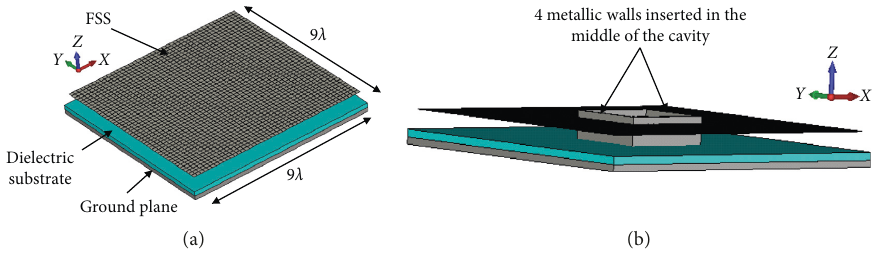
Figure 2: (a) High-gain EBG Antenna. (b) Vertical metallic walls inside the EBG antenna.